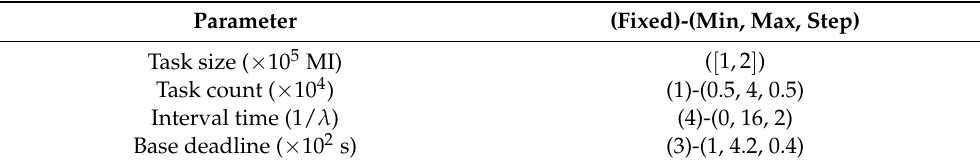
Table 2. Task parameters.